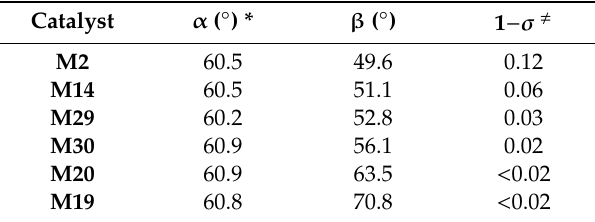
Table 2. Density Functional Theory (DFT)-calculated values of α and β angles (see text) vs. experimentally observed stereoselectivity σ for selected catalysts.